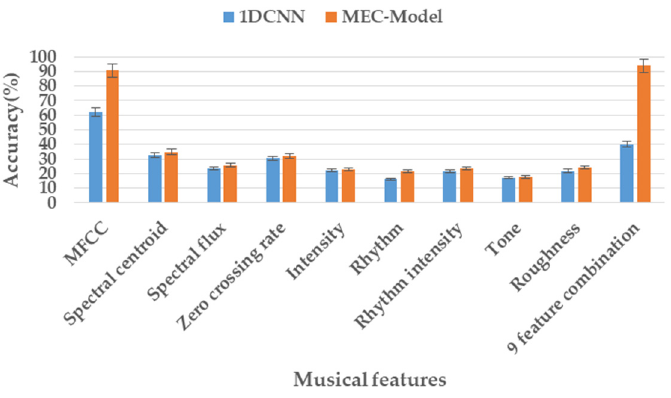
Figure 8. Audio features average accuracy comparison.